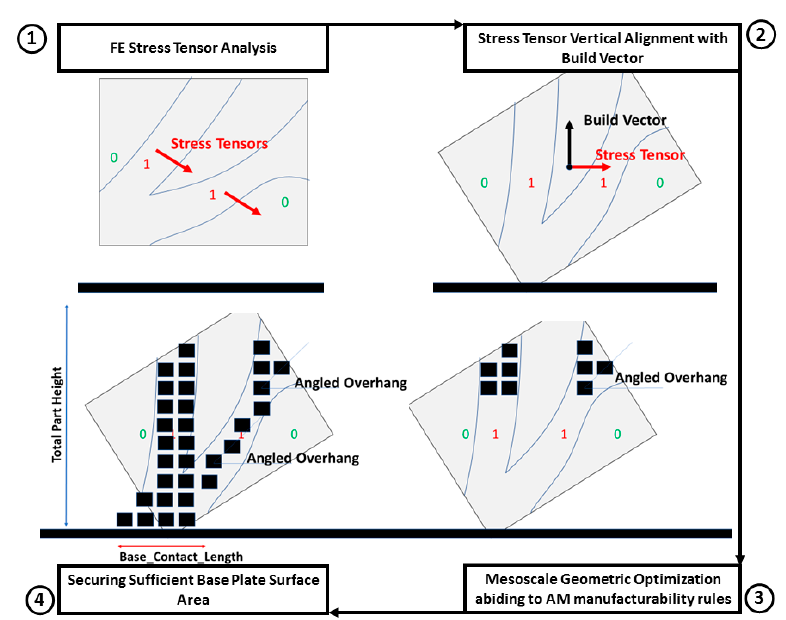
Figure 11. Shape optimization method flowchart.